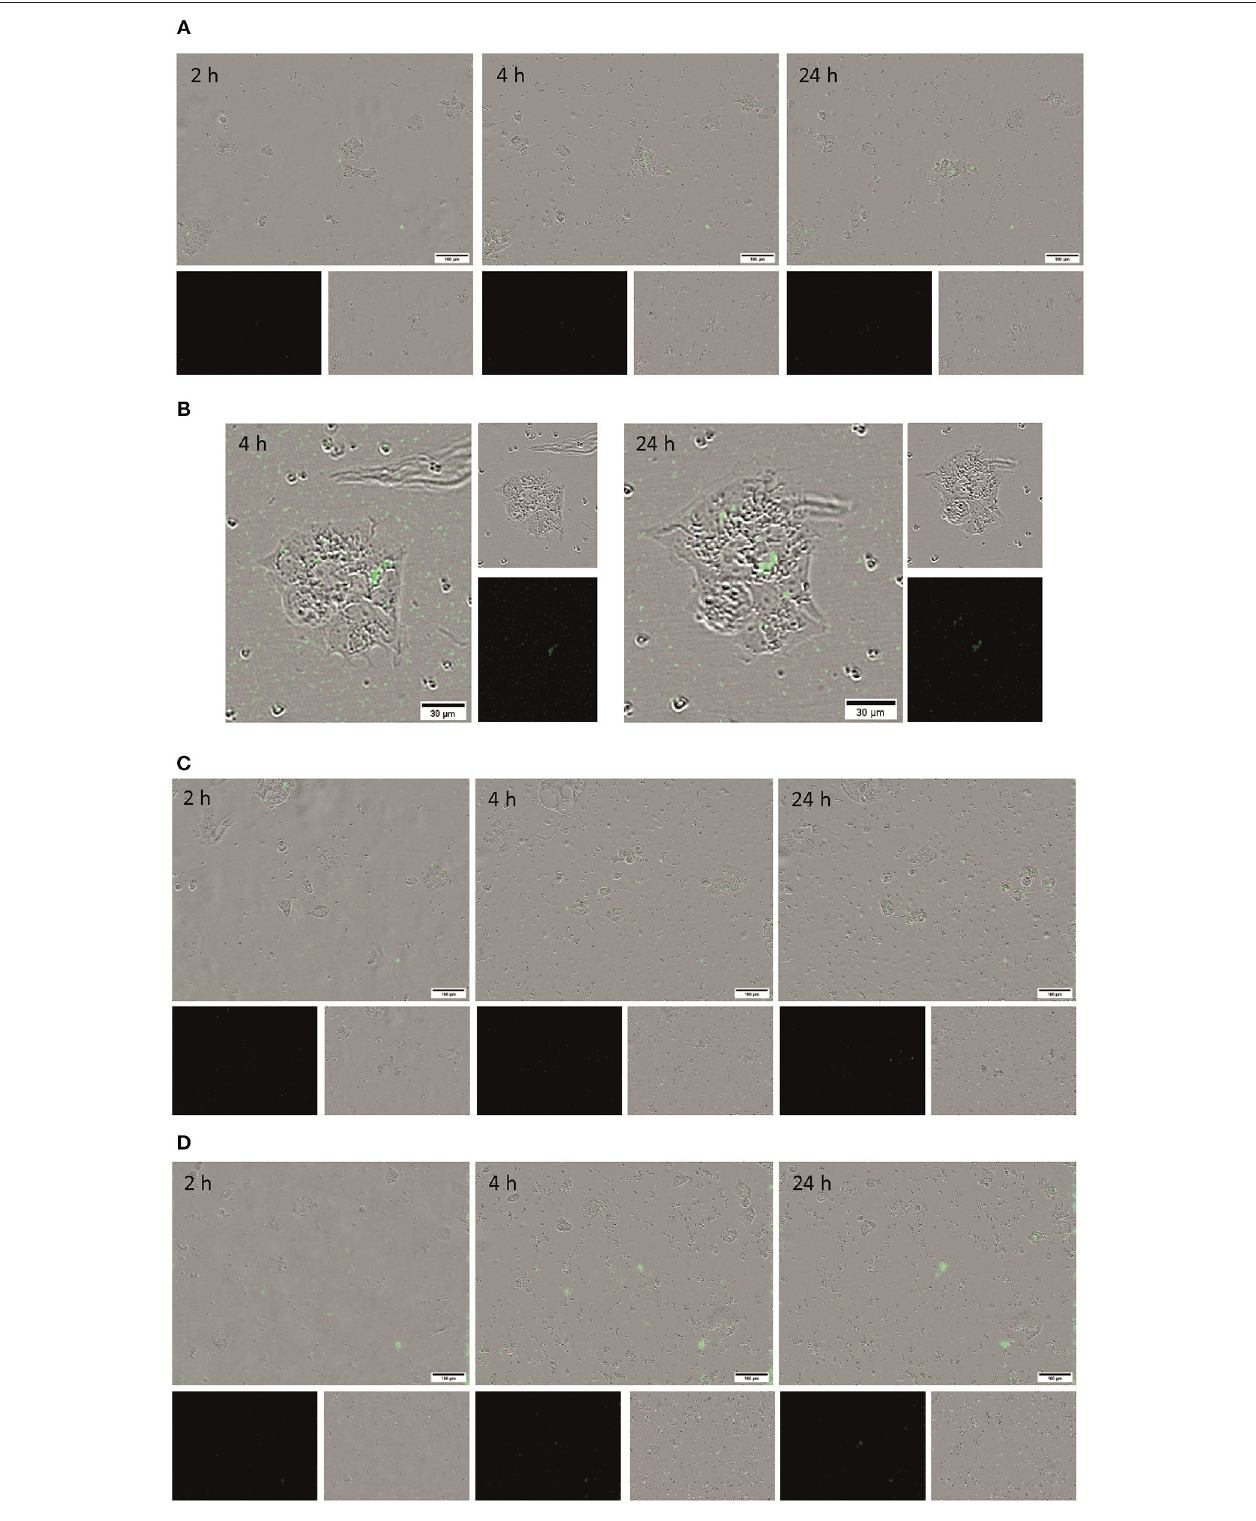
FIGURE 6 | Microphotographs of the living BT-474 cells after 2, 4, and 24h of exposure to the QD-encoded microcapsules conjugated with (A) 3 µ g, (B) 30 µ g, and (C) 300 µ g of trastuzumab and (D) QD-encoded microcapsules without protein coating as control are shown. The loaded amount of the microcapsules was 50 per